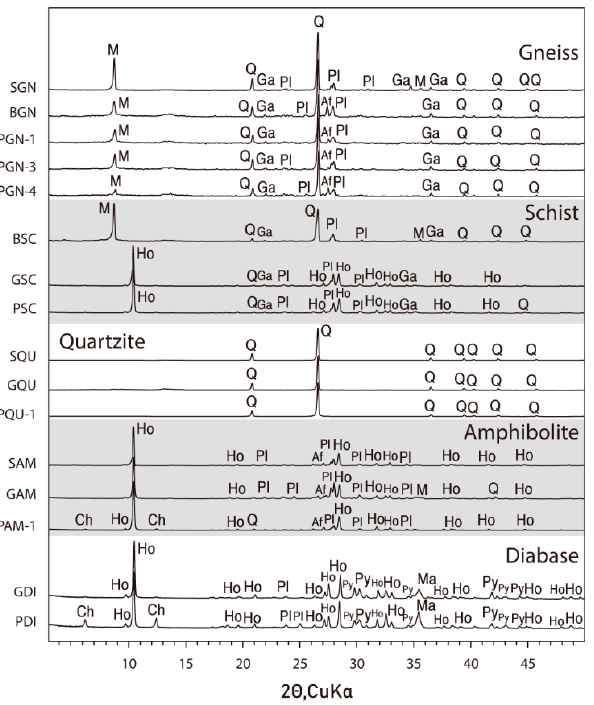
Figure 5. Result of X-ray powder diffraction analysis. Sample names are the same as in Table 1. Ch; chlorite, M; mica, Ho; hornblende, Q; quartz, Pl; plagioclase, Af; alkali-feldspar, Py; pyroxene, Ga; garnet, Ma; magnetite.